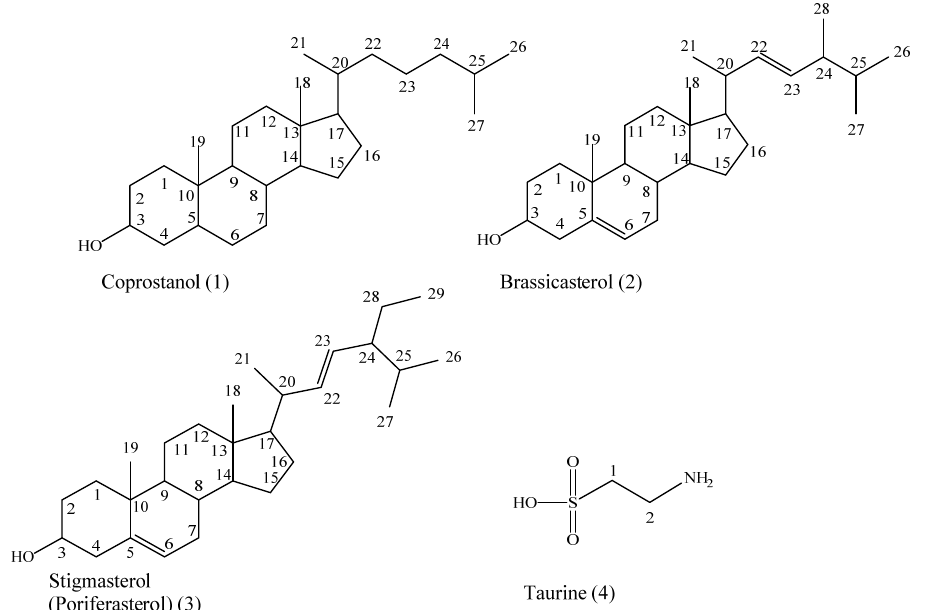
Figure 1. The chemical structures of compounds isolated from Cliona sp. Compounds 1 and 2 were obtained as a white amorphous mixture and were identi- fied as coprostanol and brassicasterol based on a comparison of their spectroscopic anal- ysis data, including EI-MS (Figure S1), GC-MS (Figures S2–S4), the ratio of coprostanol to brassicasterol (88.5% to 11.5%), 1 H-NMR, and 13 C-NMR (Table S1), with the reported lit- erature data [20–22].